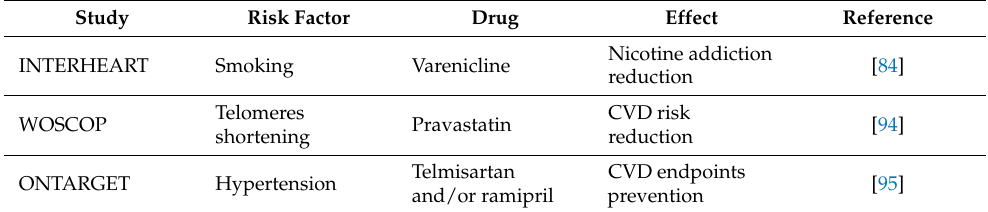
Table 1. CVD risk factors and their